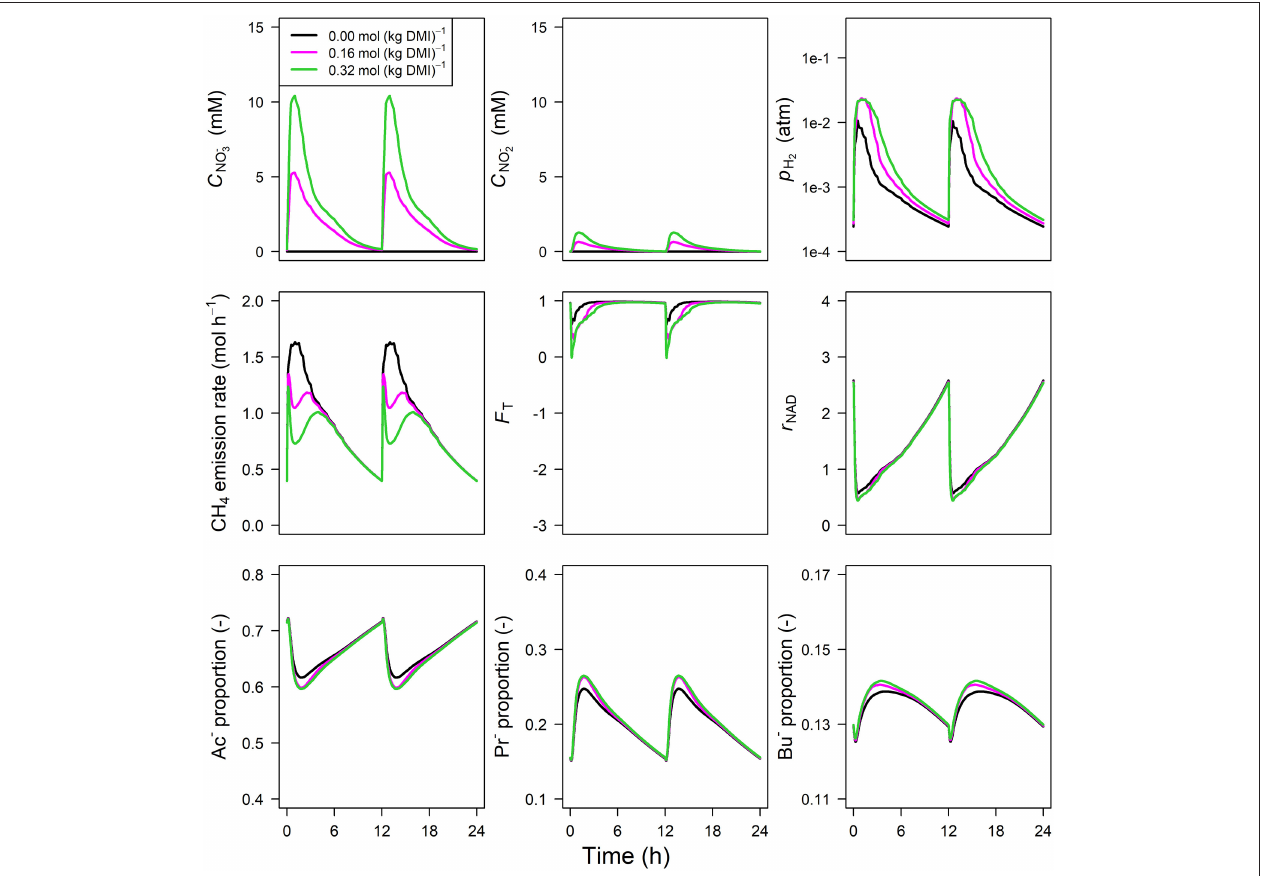
FIGURE 6 | Solutions of the NO – 3 dynamic model with NO – 2 representation for NO – 3 concentration [mM], NO – 2 concentration [mM], rumen headspace p H emission rates [mol · h − 1 ], thermodynamic potential factor ( F T ; [–]), NAD + to NADH ratio ( r NAD ), acetate proportion (Ac – ), propionate proportion (Pr – ), and butyrate proportion (Bu –